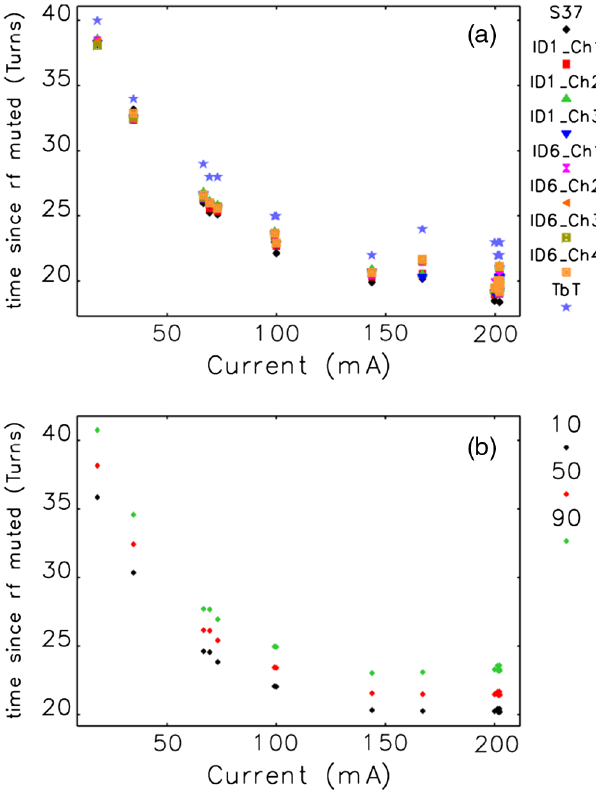
FIG. 18. Visible light emission from beam strikes during experiment 2 at (a) 69.4 mA and (b) 201.2 mA corresponding to SN02 and SN09 in Table VI. Beam is moving from right to left. The yellow dashed circles in (a) are locations where ejecta tracks appear to bend. The horizontal scale is centered on the field of view which is near the upstream end of the collimator. The apex is out of the field of view to the left of the image. The vertical scale is centered at nominal beam elevation ( y ¼ 0